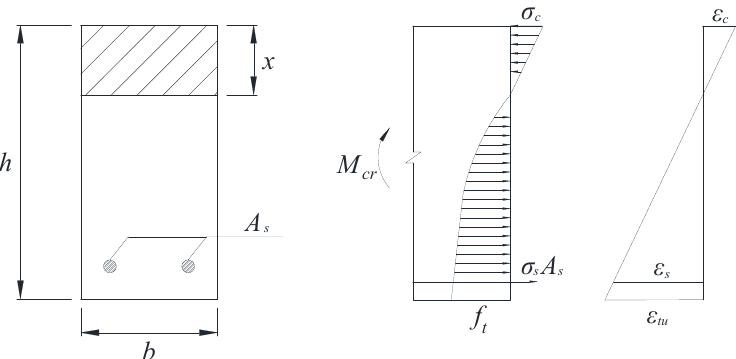
Figure 4. Calculation model of the cracking moment.